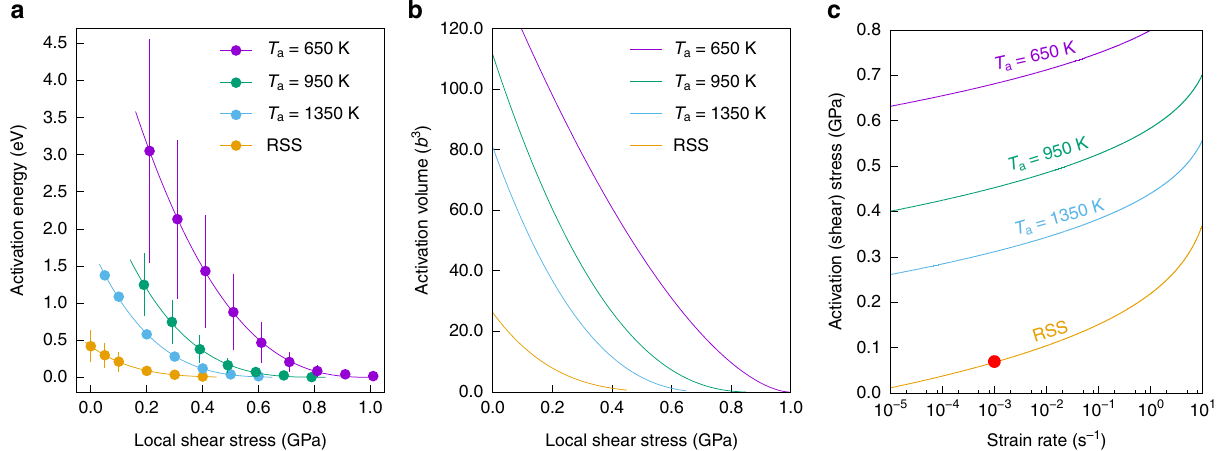
Fig. 5 Local chemical ordering (LCO)-induced strengthening. a The average activation barriers associated with the nanoscale segment detrapping process. For visualization, data for T a = 950 and 650 K are horizontally shifted by − 0.01 and 0.01 GPa, respectively. The calculated data points are fi tted using (cid:3) α Q τ ð Þ ¼ Q , where Q 0 , τ ath , and α are fi tting parameters. Error bars correspond to the standard deviations of each data point. b The average activation volume at 300 K (see Supplementary Note 6 for calculation details). c The average activation (shear) stress at 300 K as a function of strain